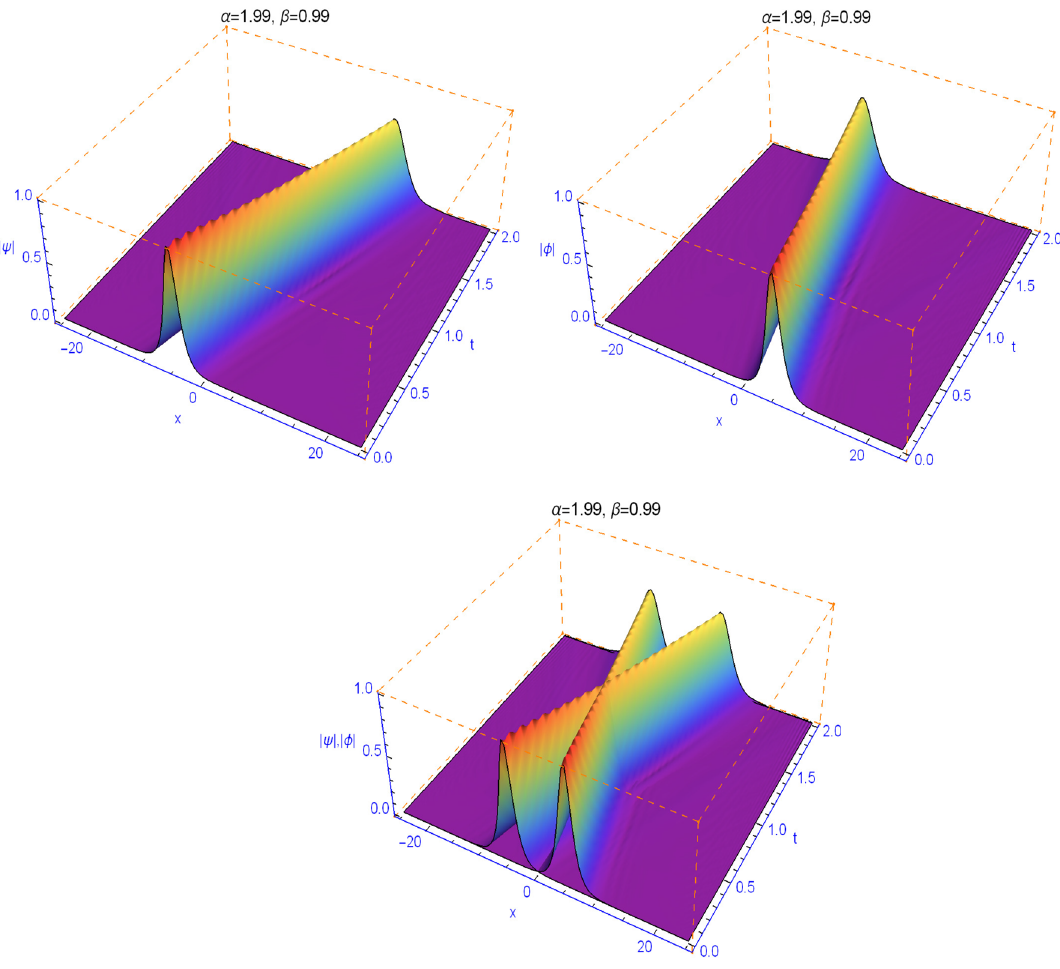
Figure 1. Plots of model (36) for β = 0.99 and α = 1.99